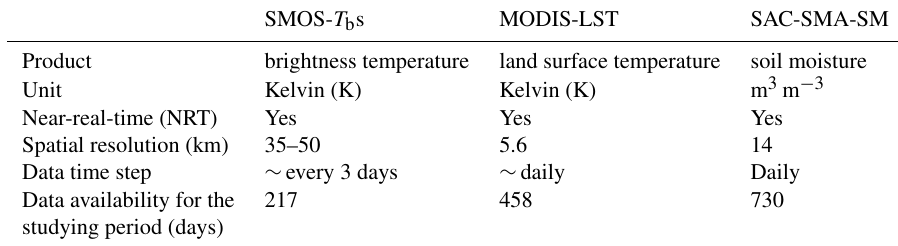
Table 2. General data-input properties relevant for this